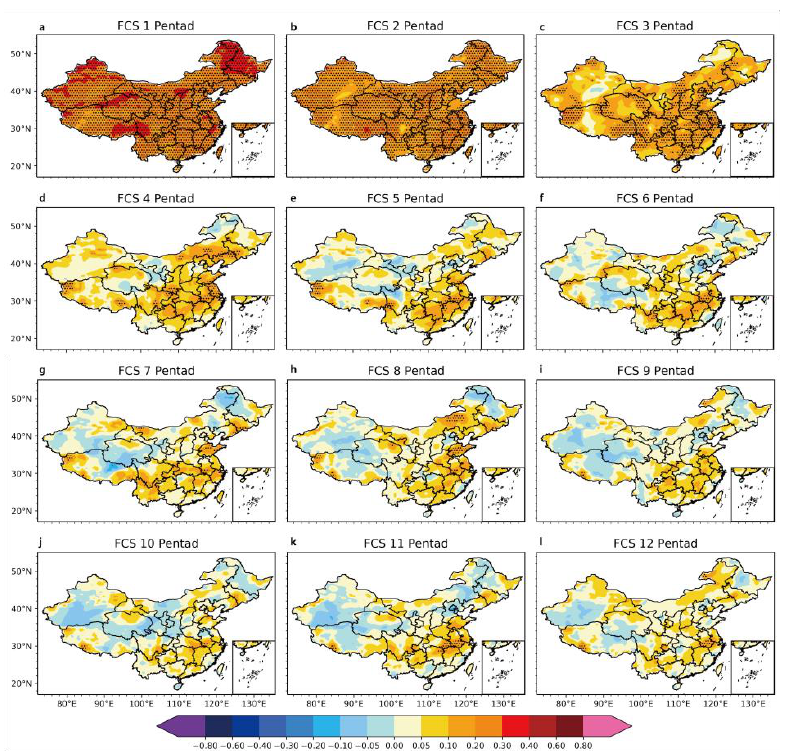
Figure 7. Spatial pattern of the annual average TCC for the 1 – 12 ( a – l , respectively) pentad precipitation forecast of the pentad DSDM from 2000 to 2018. The dotted regions are where the TCC passed the 95% significance test.